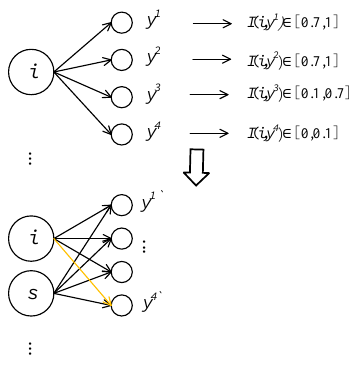
Figure 7. Neuron i splits into two, disconnects i from y 4 .